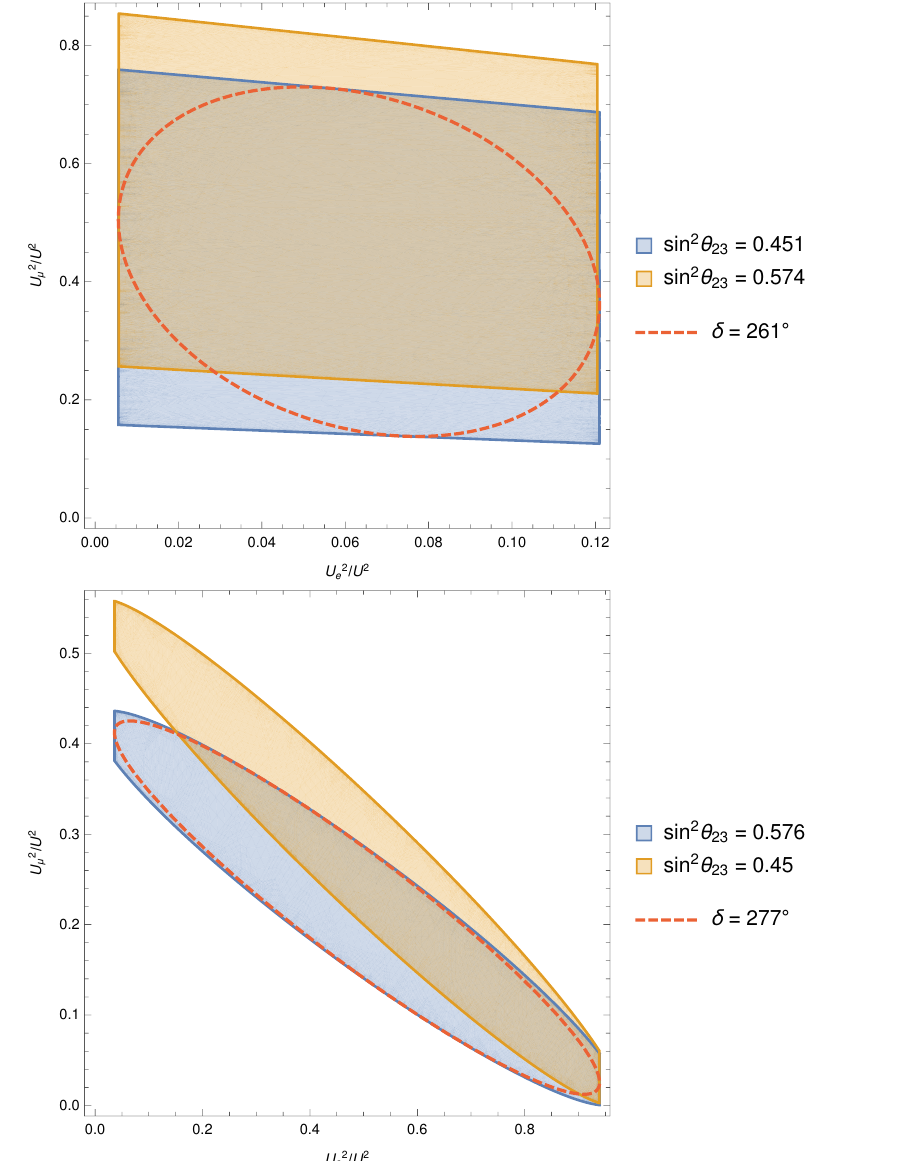
Figure 1 . The coloured regions indicate the allowed range of U 2 =U 2 that can be realised by a varying the phases in U (cid:23) after (cid:12)xing the light neutrino mass splittings and mixing angles to their best (cid:12)t values given in table 1. U 2 =U 2 is (cid:12)xed by the requirement P U 2 =U 2 = 1. The di(cid:11)erence (cid:28) a a between the orange and blue region illustrates the change of the predictions if one varies these parameters within their experimental uncertainties. The upper panel assumes normal light neutrino mass hierarchy, the lower panel assumes inverted hierarchy. If the Dirac phase (cid:14) is measured independently in light neutrino oscillation experiments, the two dimensional regions will reduce to rings in the U 2 =U 2 - U 2 =U 2 plane as demonstrated by the red dashed lines, where we take the best e (cid:22) (cid:12)t values for (cid:14) = 261 (cid:14) for normal hierarchy with sin 2 (cid:18) 23 = 0 : 451 and (cid:14) = 277 (cid:14) with sin 2 (cid:18) 23 = 0 : 576 for inverted hierarchy. Note that we assume here (cid:15); (cid:22) (cid:28) 1, while for non-small (cid:15) (for smaller Im ! ) the shape and size of the coloured region changes. It is worth mentioning that the Dirac phase (cid:14) has not been measured at a signi(cid:12)cant level. Therefore, (cid:14) remains an free parameter throughout this paper unless speci(cid:12)ed.